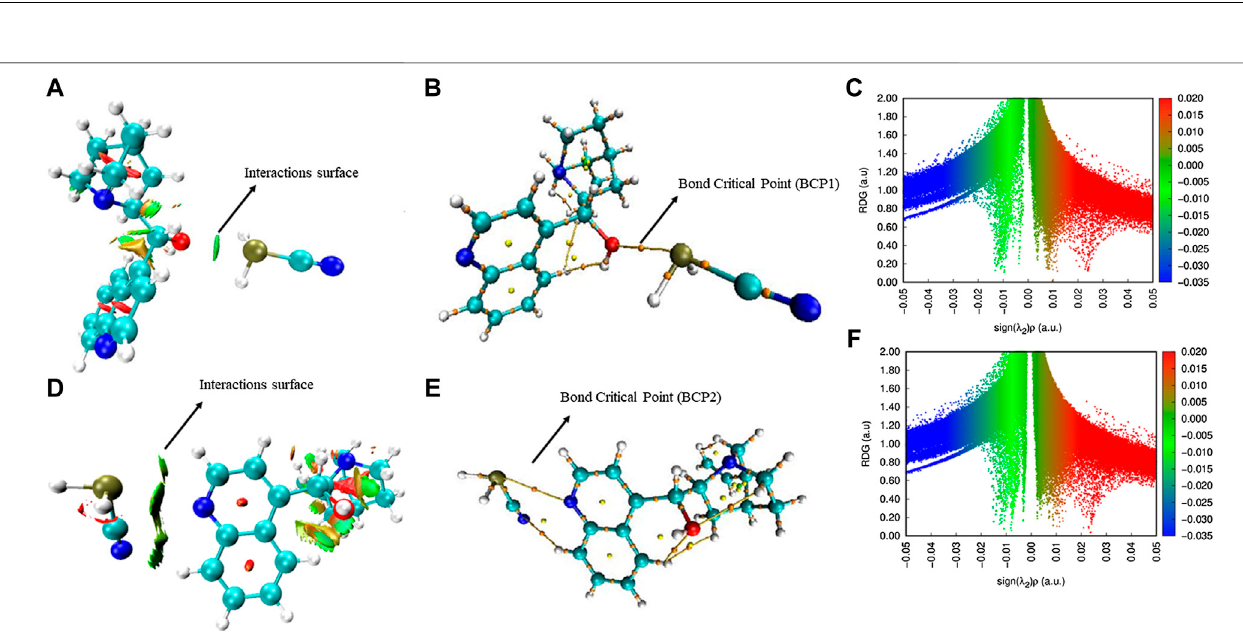
Frontiers in Chemistry |